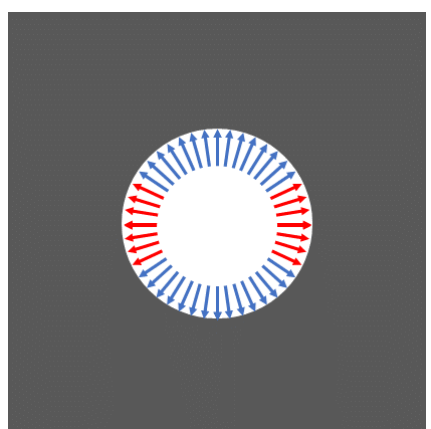
Figure 10. Schematic diagram of loading on the borehole (The red arrows and the blue arrows represent the impact load of the primary impact direction and the secondary impact direction, respectively). Table 2. Dynamic parameters of the